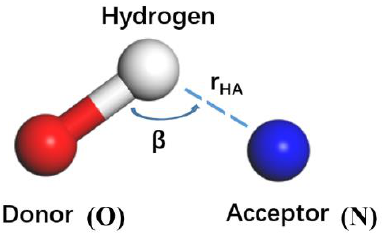
Figure 10. The schematic diagram of a hydrogen bond.